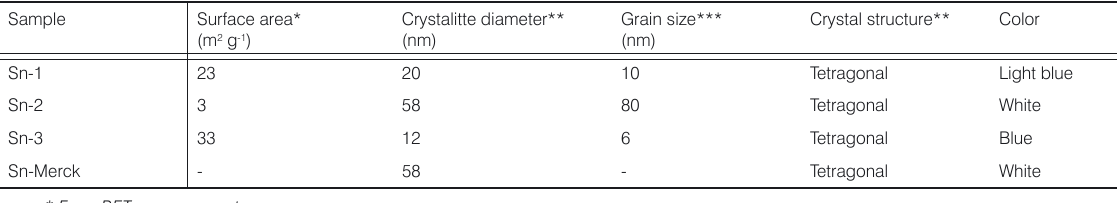
Table 1. Surface area, grain sizes, crystal structure and colors of synthesized